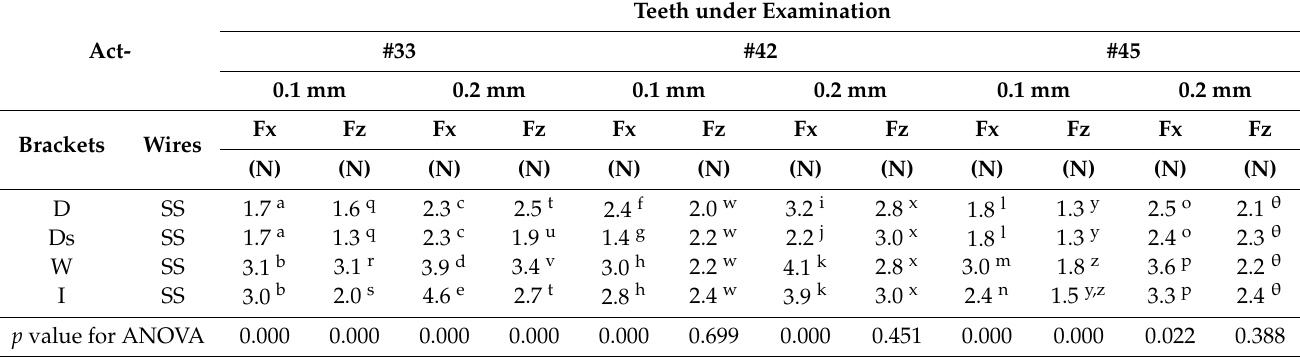
Table 5. Intrusion/extrusion and orovestibular force values generated during negative activation at a specific tooth (canine, lateral incisor and premolar) area using the four different bracket appliances combined with the stainless-steel wire at 0.1 mm and 0.2